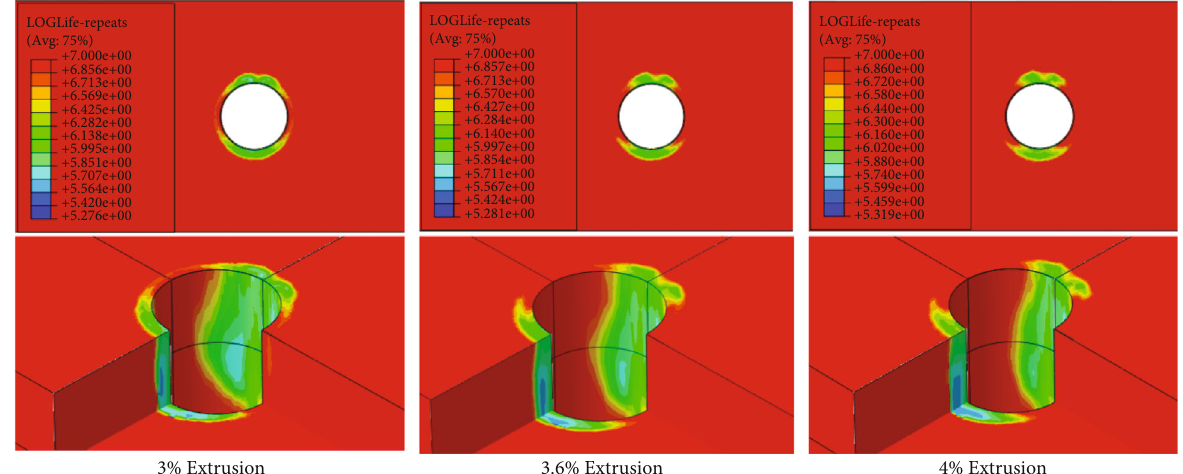
Figure 15: Fatigue life cloud diagram under di ff erent squeeze